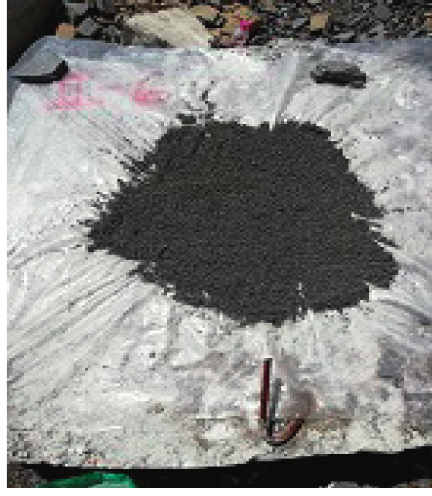
Figure 8: Blasting volume measurement. Table 6: Error analysis table of blasting volume fitting formula. Cutting